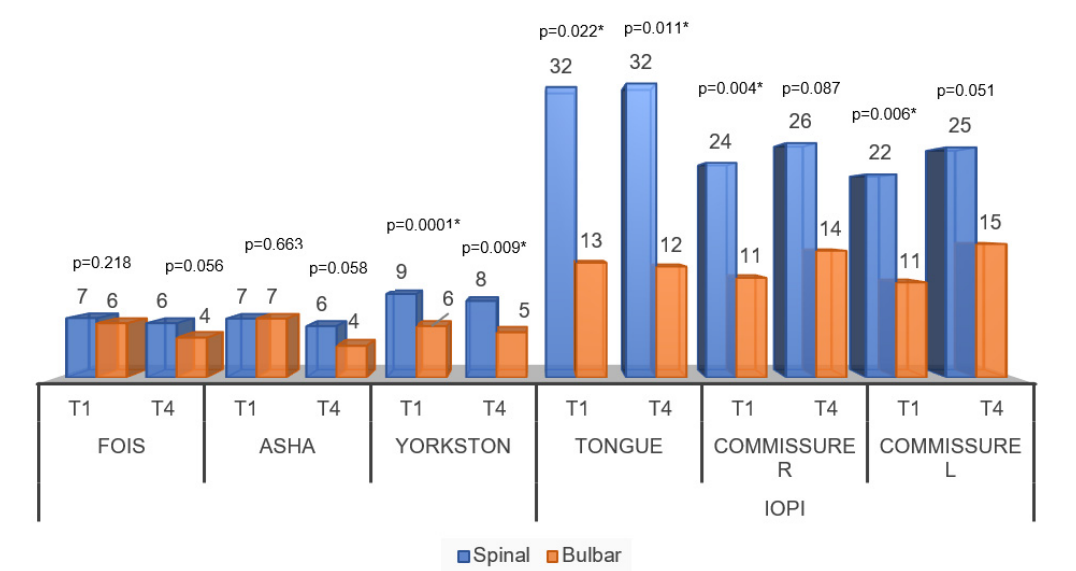
Figure 4. Averages of the comparisons of speech-language assessment measures between the diagnostic groups. Abbrevi- ations: FOIS (Functional Oral Intake Scale); ASHA (Swallowing Rating Scale of the American Speech-Language-Hearing Association); Speech intelligibility by Yorkston); Commissure R (Commissure right); Commissure L (Commissure left); IOPI (Iowa Oral Performance Instrument). Significance determined using the Mann–Whitney test; * p < 0.05.